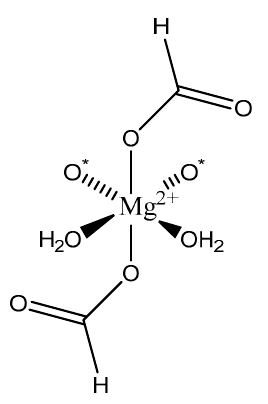
Figure 9. Structure illustration of formic acid .